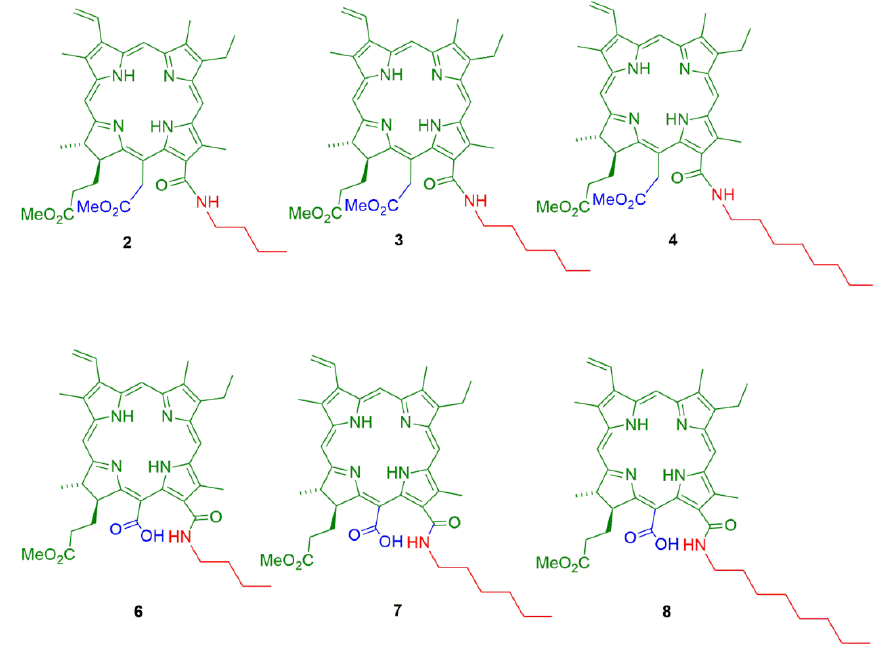
Figure 1. Chlorophyll a derivatives 2 – 4 and 6 – 8 .